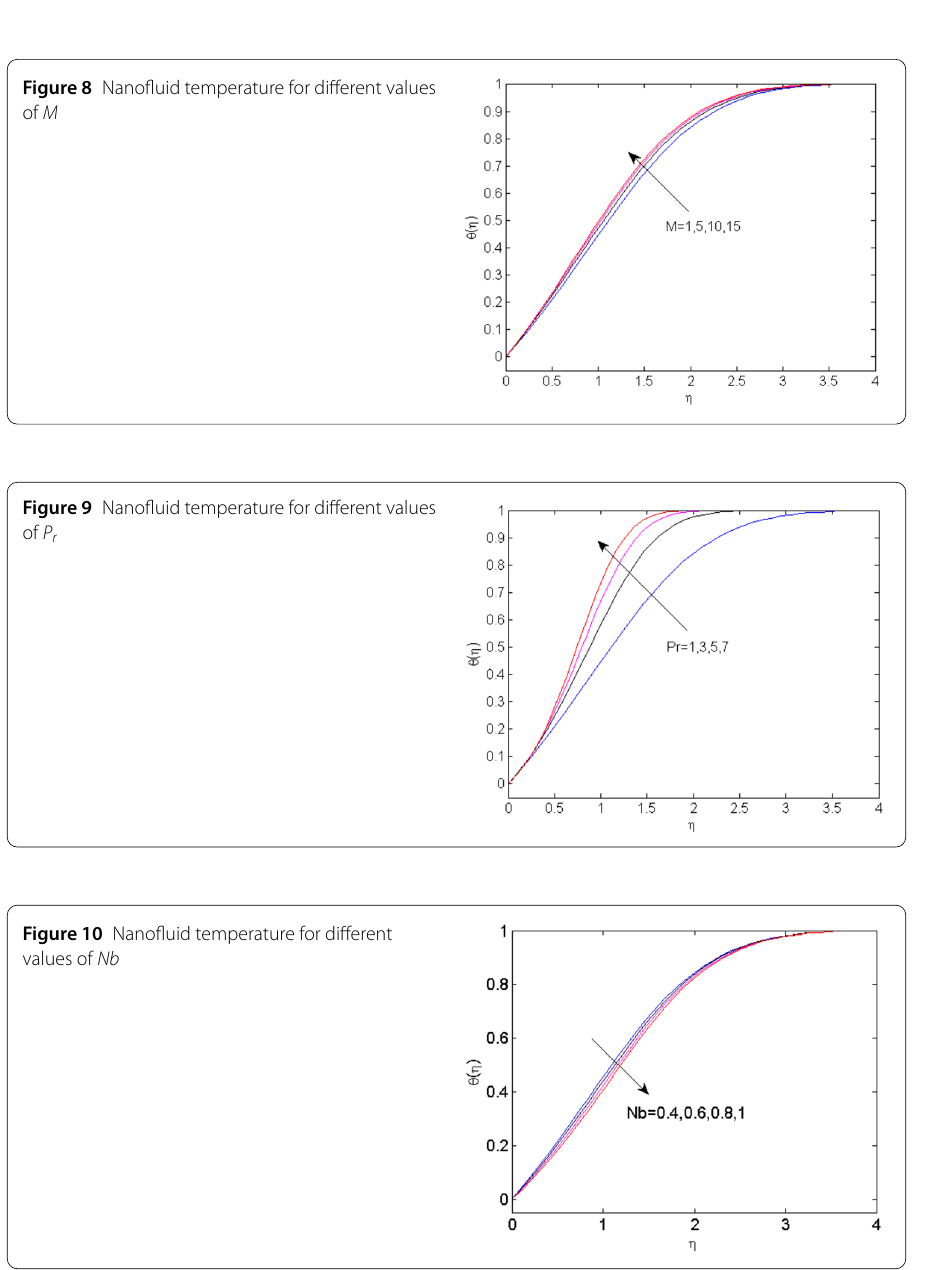
Figure 10 Nanofluid temperature for different values of